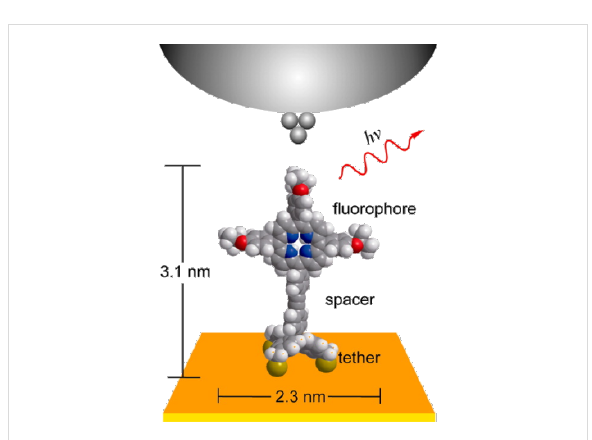
Figure 17: Schematic configuration of 38 on Au(111) and localized electrical excitation from a nanotip. Reprinted with permission from [74], copyright 2013 American Chemical